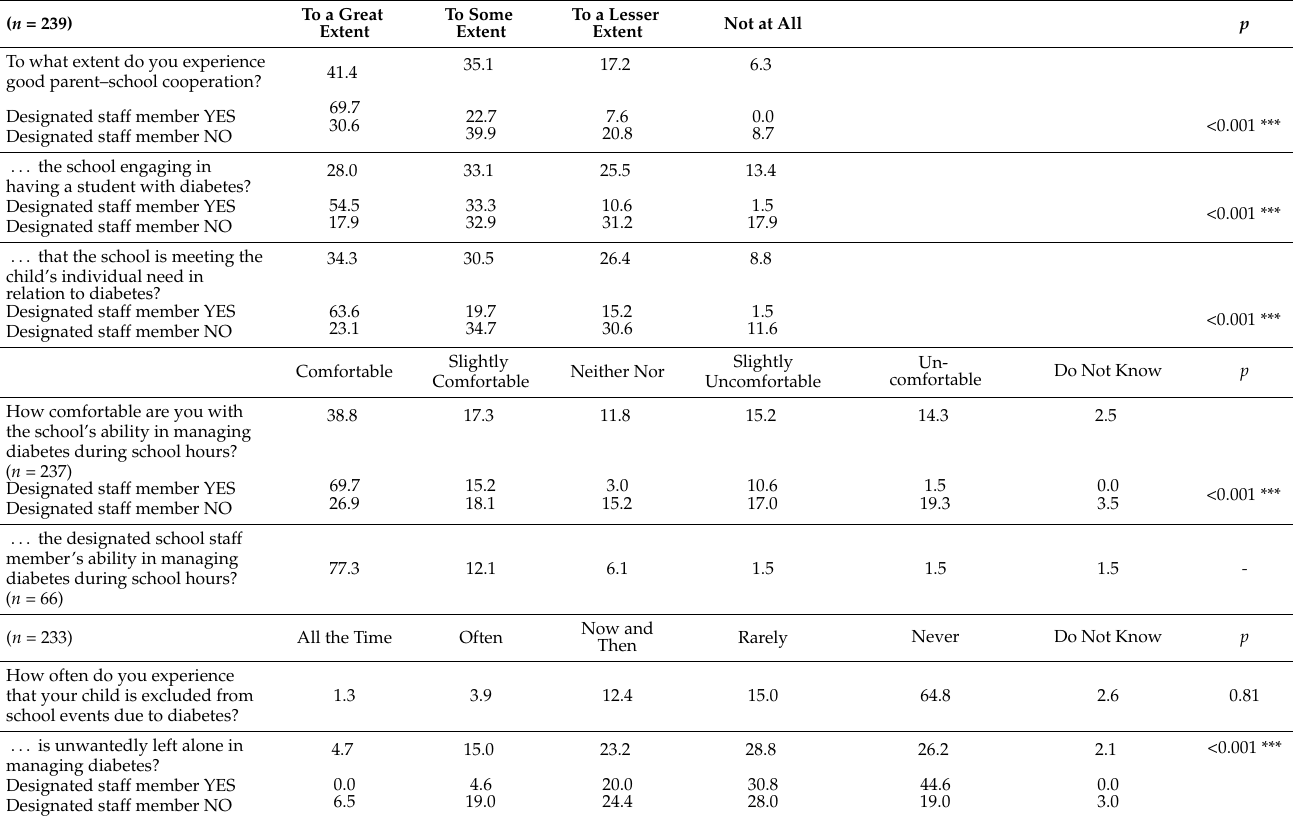
Table 4. A selection of questions and answers within the theme: Diabetes care in school. All questions are worded with emphasis on the time prior to the COVID-19 pandemic. The answers are presented in total frequencies (%) and significant associations ( p < 0.05), stratified for status for designated staff member (YES/NO), are also